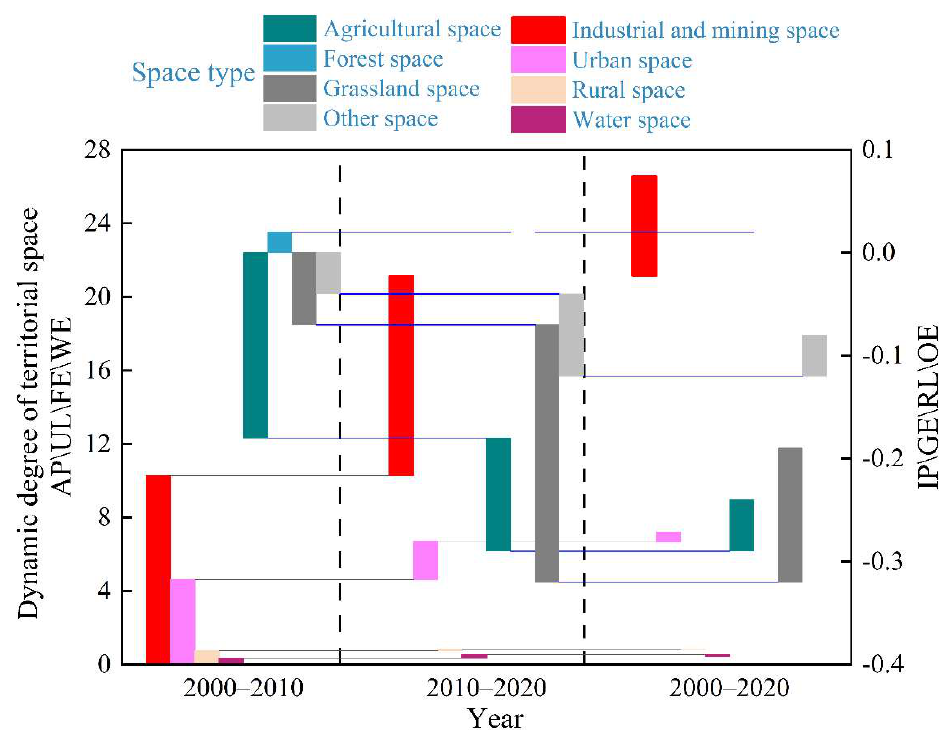
Figure 8. Evolution of the dynamic degree of territorial space in the Yangtze River Economic Belt from 2005 to 2015.